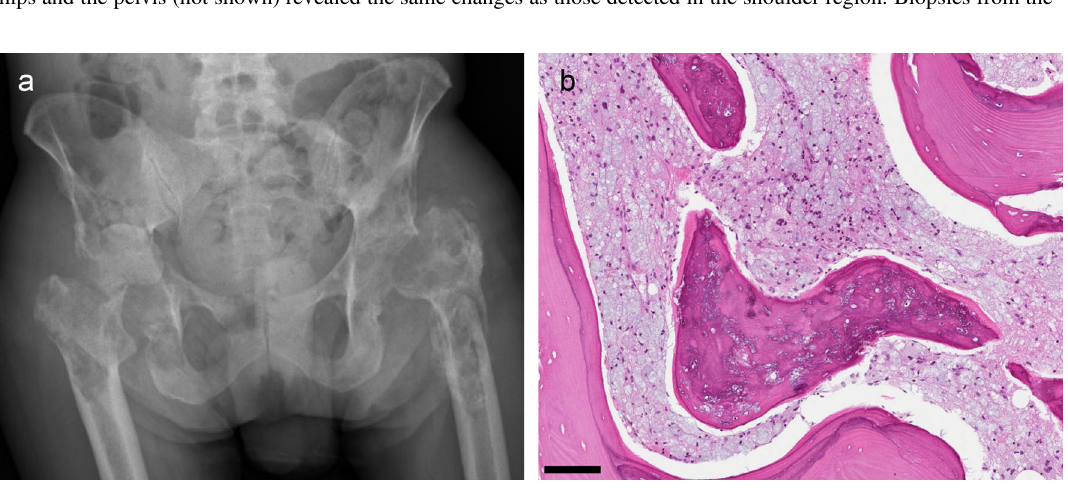
Figure 3. Pathological fractures and bone destruction: radiological and biopsy findings. (a) Pelvic radiograph. Left hip: The hip prosthesis has been removed due to loosening and replaced by a Girdlestone hip. Right hip: Extensive lytic and sclerotic changes in the proximal femur and acetabulum leading to medial dislocation of the femoral head. (b) Biopsy from the right greater trochanter (H&E): The marrow space is filled with histiocytes with the bluishvacuoles characteristic ofPVP-deposition. Thebonetrabecula hasemptylacunar spacesandcontains abluish material. Scale bar 50 μ m.